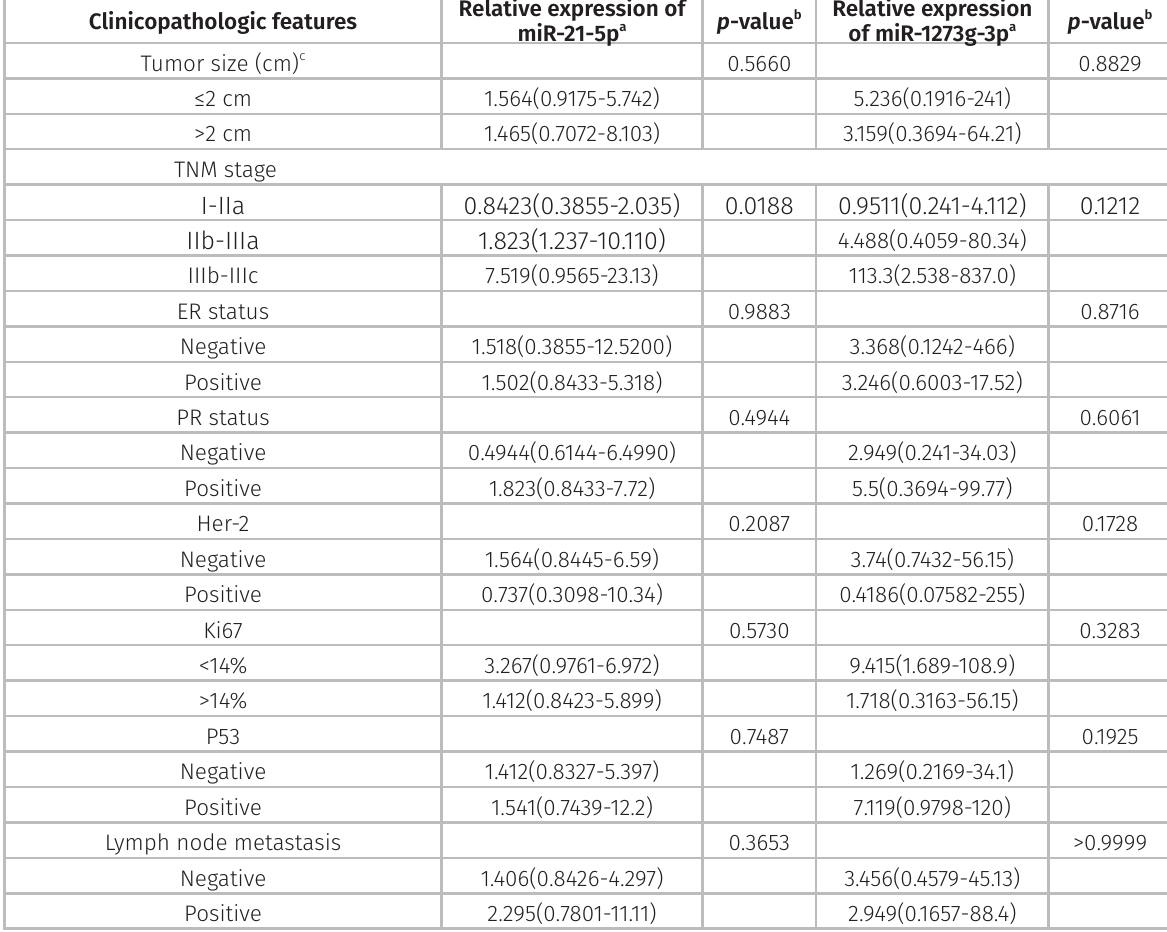
Table II. Correlation of the expression of plasma miRNA with clinicopathologic